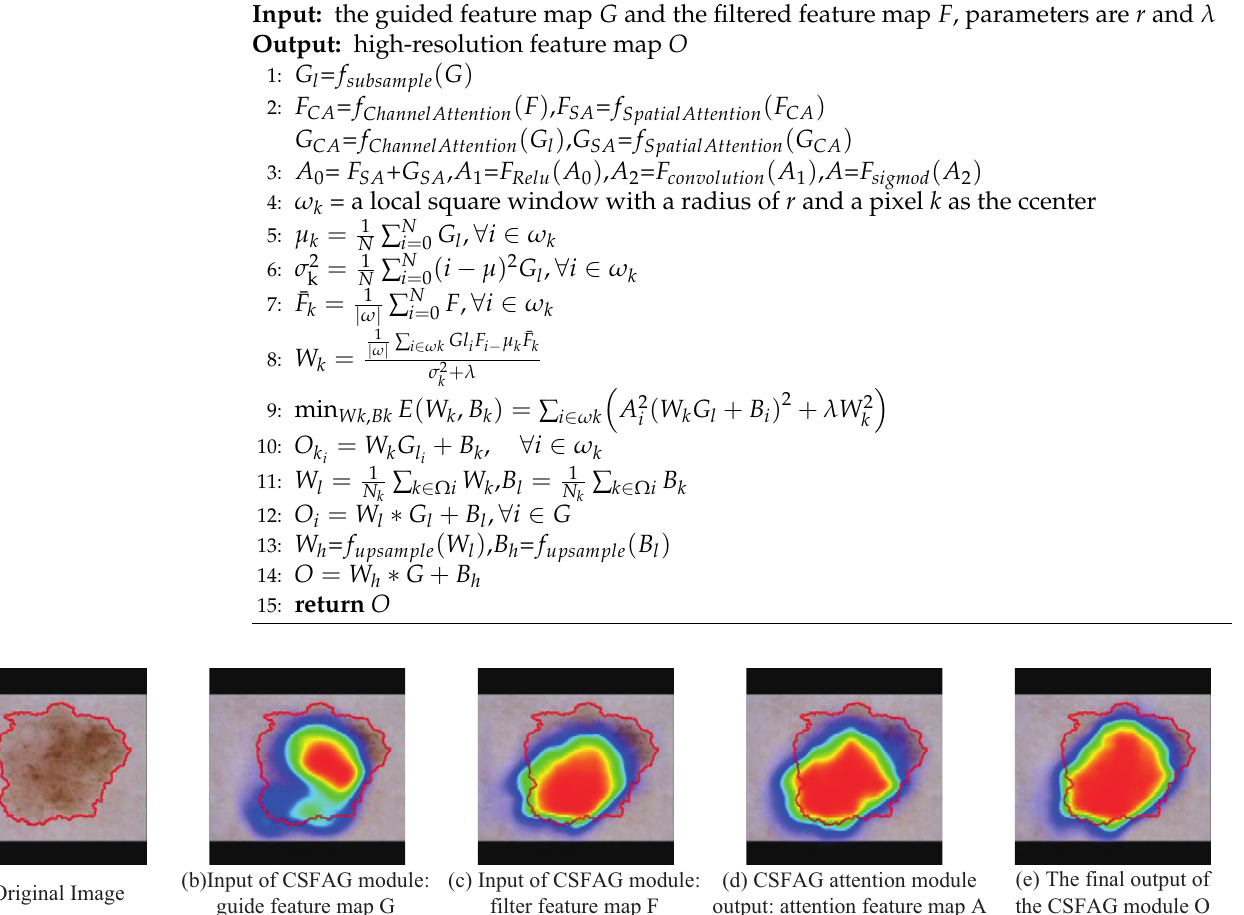
Algorithm 1 Channel Spatial Fast Attention-guided Filter